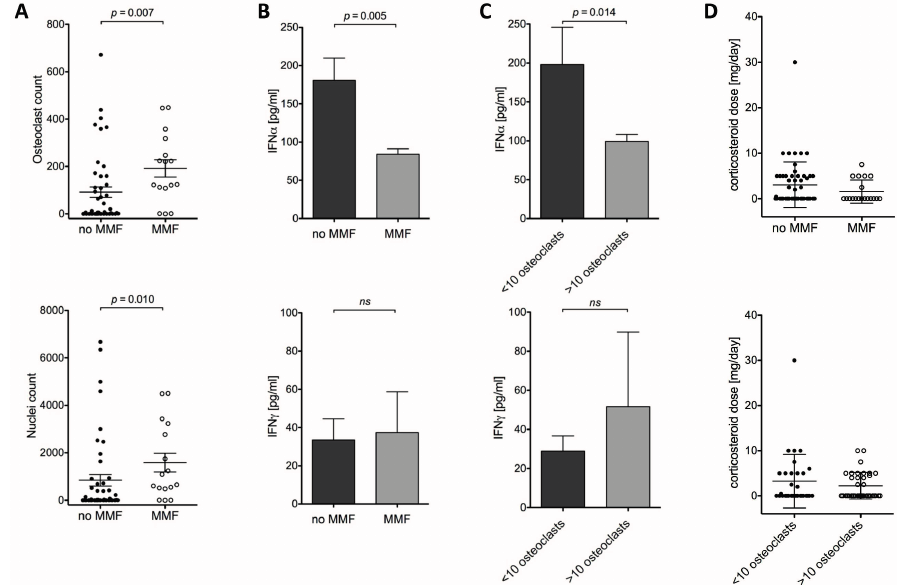
Figure 2. SLE patients without MMF therapy have a lower osteoclast count and higher IFN α levels in serum. ( A ) Patients with SLE with mycophenolate mofetil (MMF) treatment have significantly higher numbers of osteoclasts and nuclei generated in vitro compared to patients without MMF; ( B ) SLE patients with very low osteoclast count (<10) or without MMF treatment have higher serum IFN α levels; ( C ) No difference of IFN γ levels in plasma of SLE patients was detected; ( D ) The corticosteroid dose was not significantly different between patients with MMF or without MMF treatment or between patients with low or normal osteoclast counts; p Values were calculated by Mann-Whitney U test; ns: not